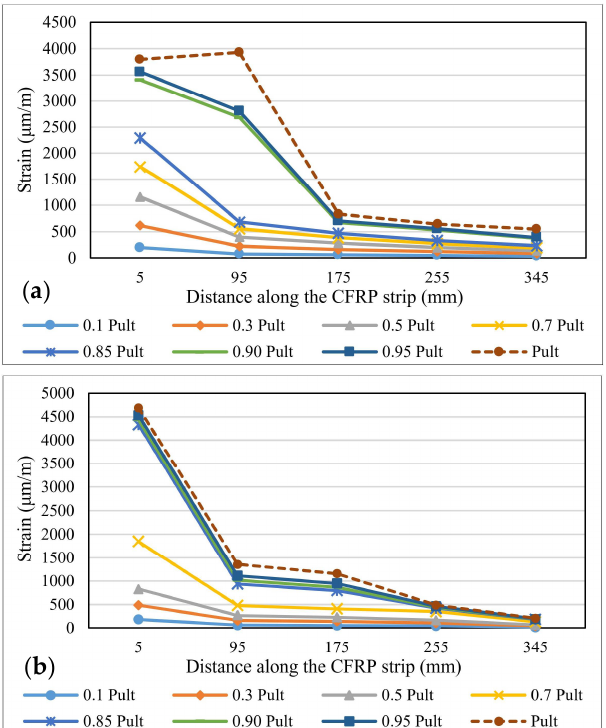
Figure 11. Strains distribution along the bond length for specimens: ( a ) S-S512-330-1-I and ( b ) S-M514-330-3-I.